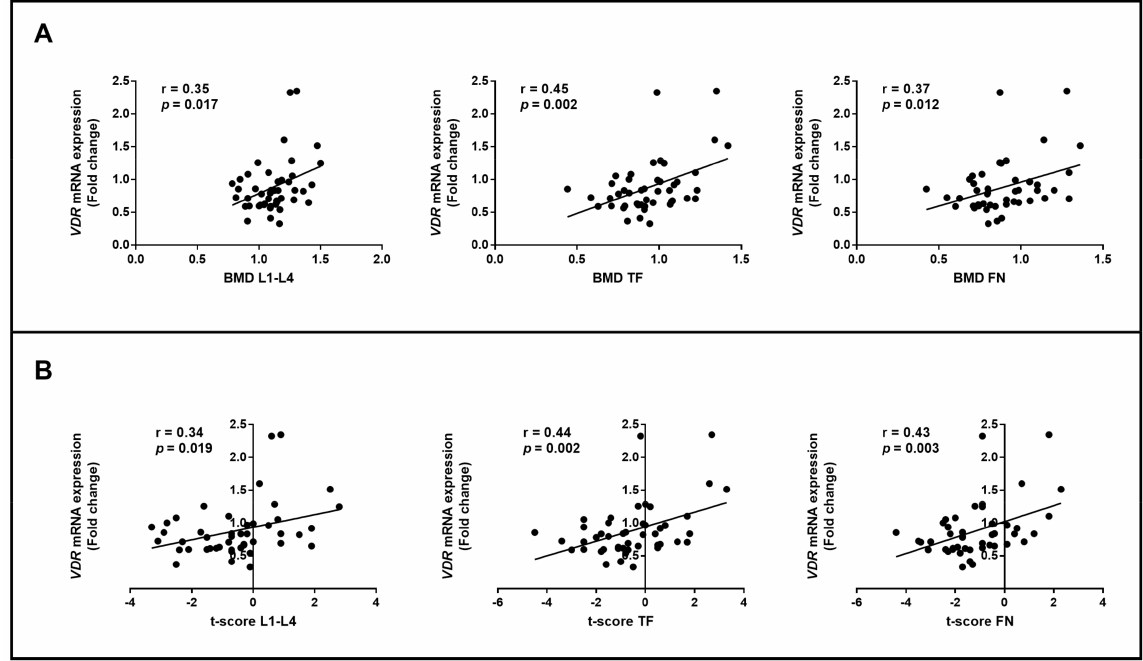
Figure 3. Correlation between VDR expression levels and instrumental clinical characteristics of OP and CTR subjects. VDR expression levels were determined by qRT-PCR; each point represents one subject. VDR levels were positively associated with BMD ( A ) and t -score ( B ) values of the L1–L4 lumbar spine, total femur and femoral neck. Pearson’s correlation values (r) are indicated in each graph.